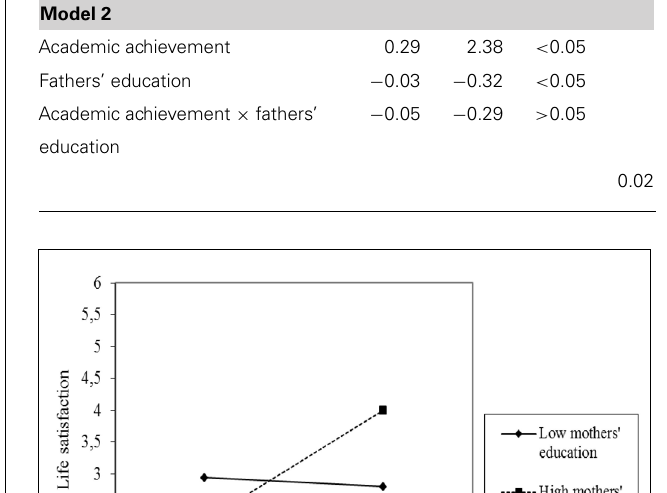
FIGURE 1 | Relationship between academic achievement [grade point average (GPA)] and life satisfaction (LS), r = 0.14.